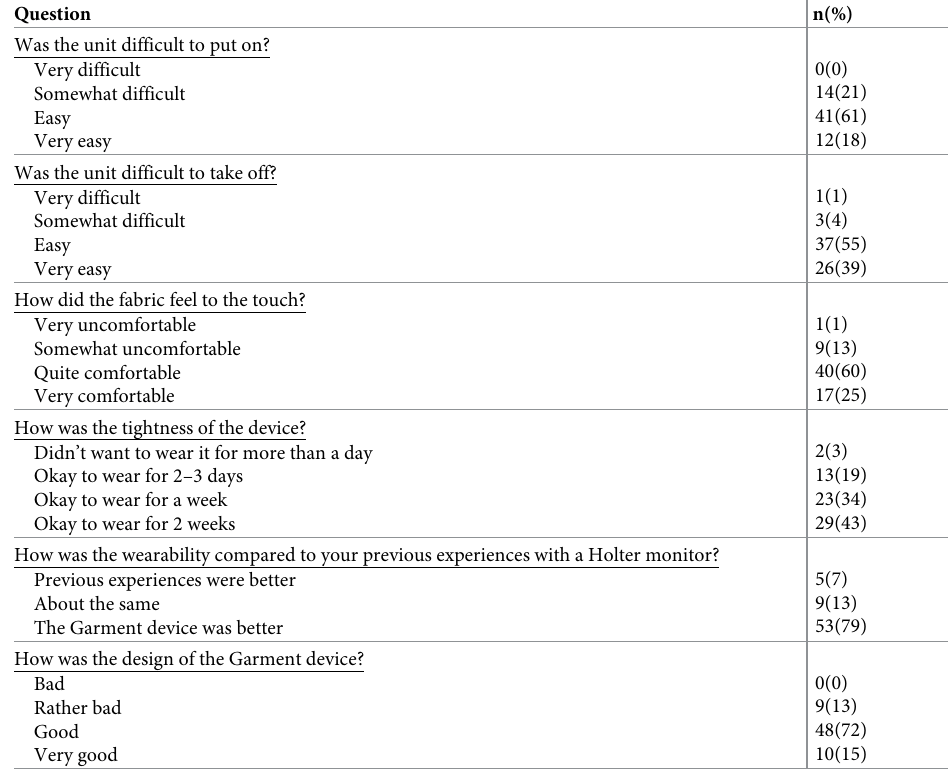
Table 3. Results from questionnaire on wearability of the garment ECG device (secondary endpoint). Question n(%) Was the unit difficult to put